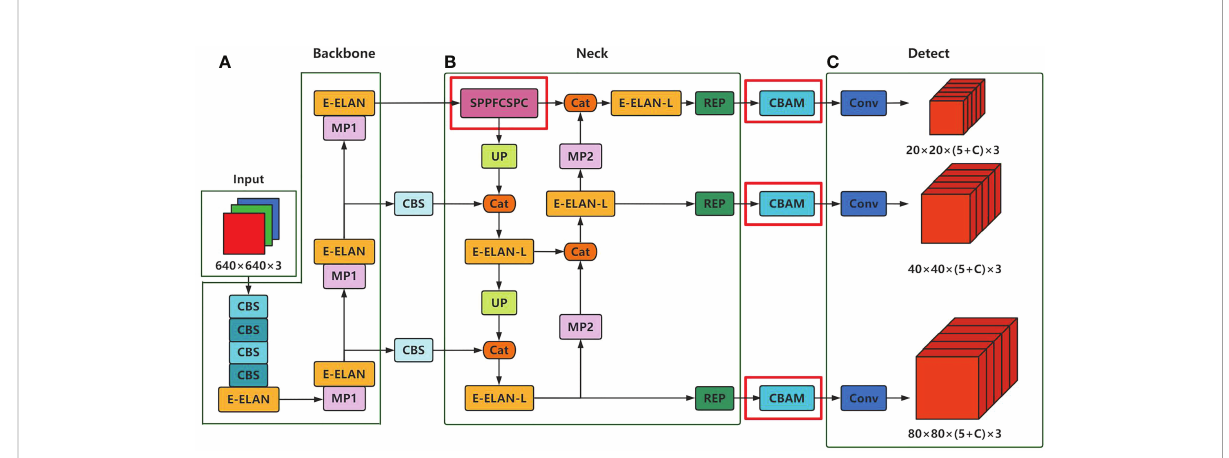
FIGURE 1 Overall architecture diagram of the model. Where (A) denotes the backbone network for feature extraction, (B) denotes the neck network for feature fusion, (C) denotes the detect network used to obtain the model prediction results, and C denotes the number of categories in the